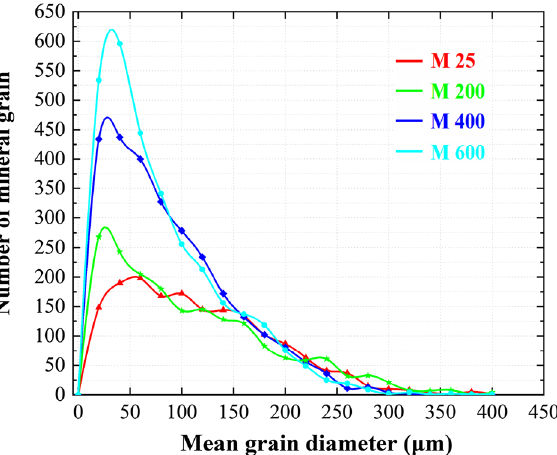
Figure 7. Evolution of grain size distributions of the marble samples exposed to different treating temperatures.